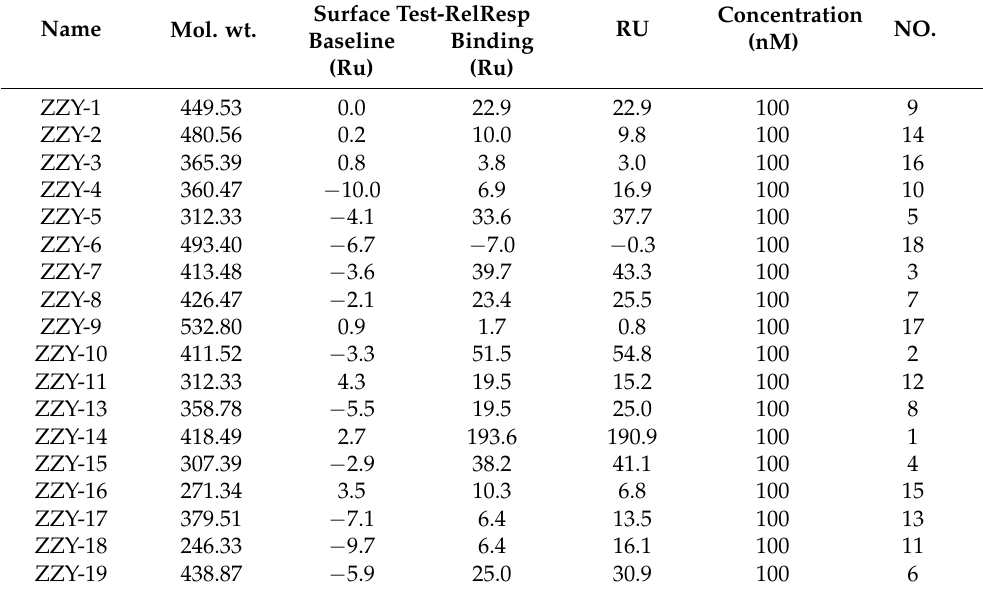
Figure 5. Structure-based virtual screening for the discovery and validation of ULK1 inhibitors ( A , B ) Effects of the ULK1 inhibitors on the proliferation of HepG2 and HCCLM3 cells. The inhibition rates were calculated by comparing with the control group; ( C ) The kinetic interactions of the ULK1 protein and ZZY-19 were determined by SPR analyses. The indicated concentrations of ZZY-19 were passed over immobilized ULK1 on CM5 sensor chips. The affinity constants were evaluated using BIA evaluation software. * p < 0.05. Table 3. Surface test of the small molecules on ULK1 captured by CM5.